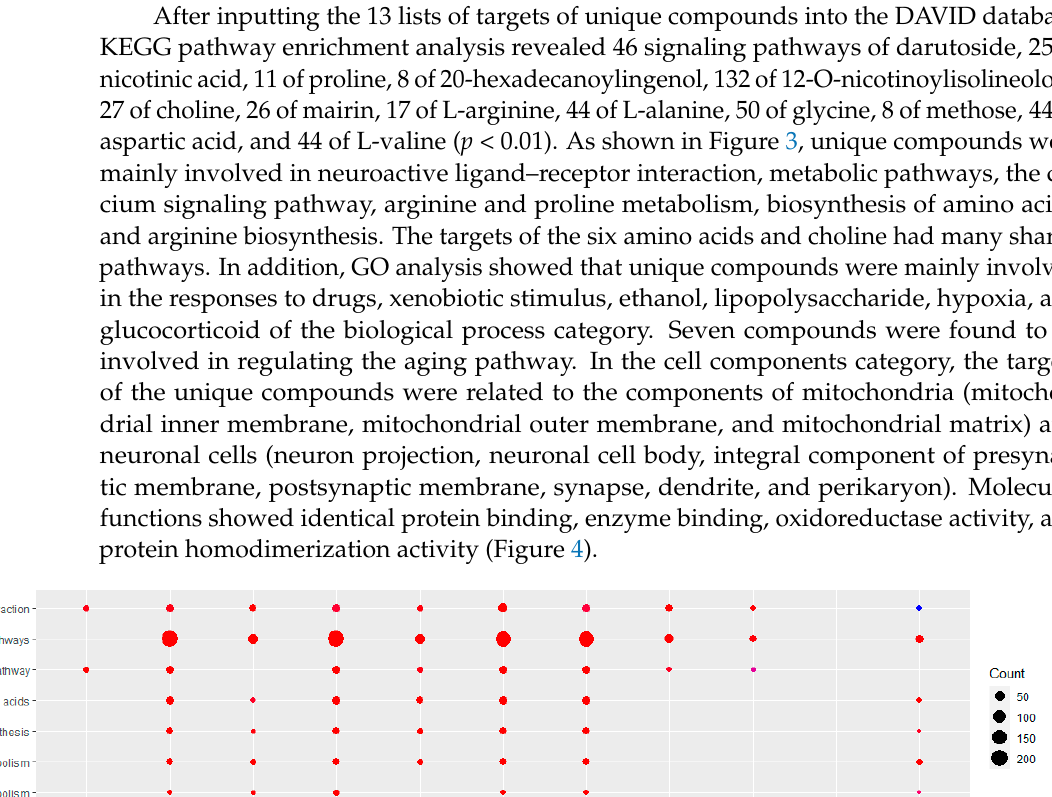
no connection to the pathways were removed), and 13 main